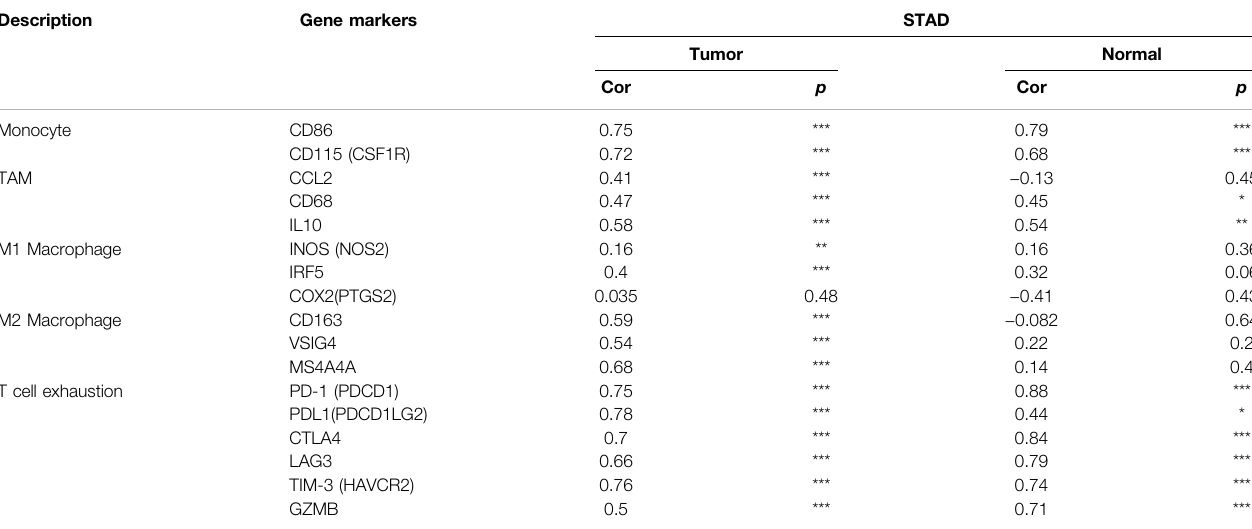
TABLE 3 | Correlation analysis between ITGAL and related genes and markers of monocyte, macrophages, and T-cell exhaustion in Gene Expression Pro fi ling Interaction Analysis (GEPIA). Description Gene markers STAD